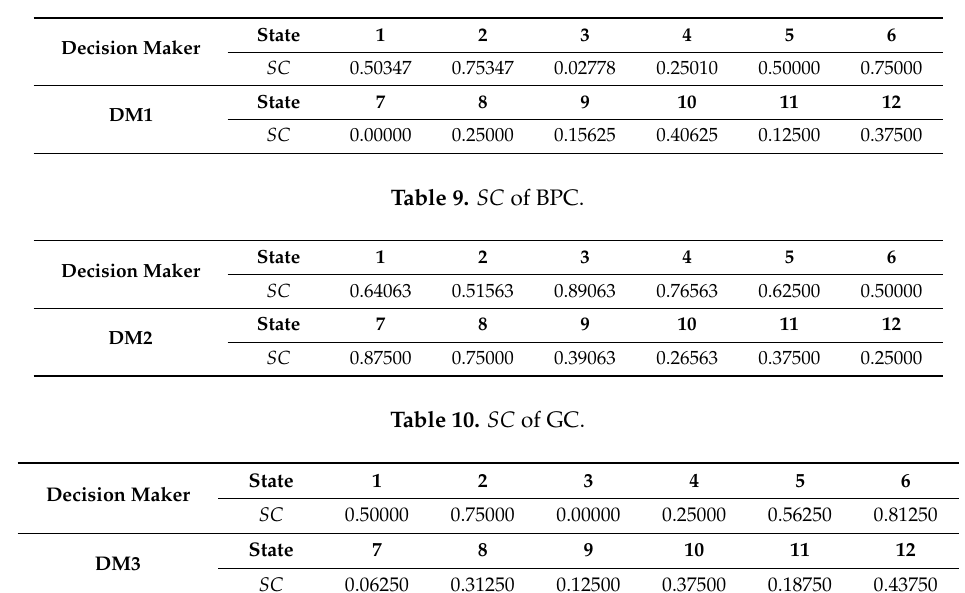
Table 8. SC of EPA.